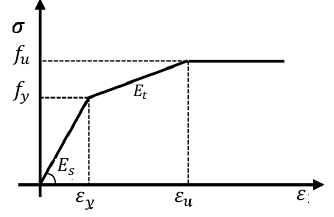
Figure 11. Stress–strain relationship for steel material. Table 4. Material properties of steel in the numerical model.